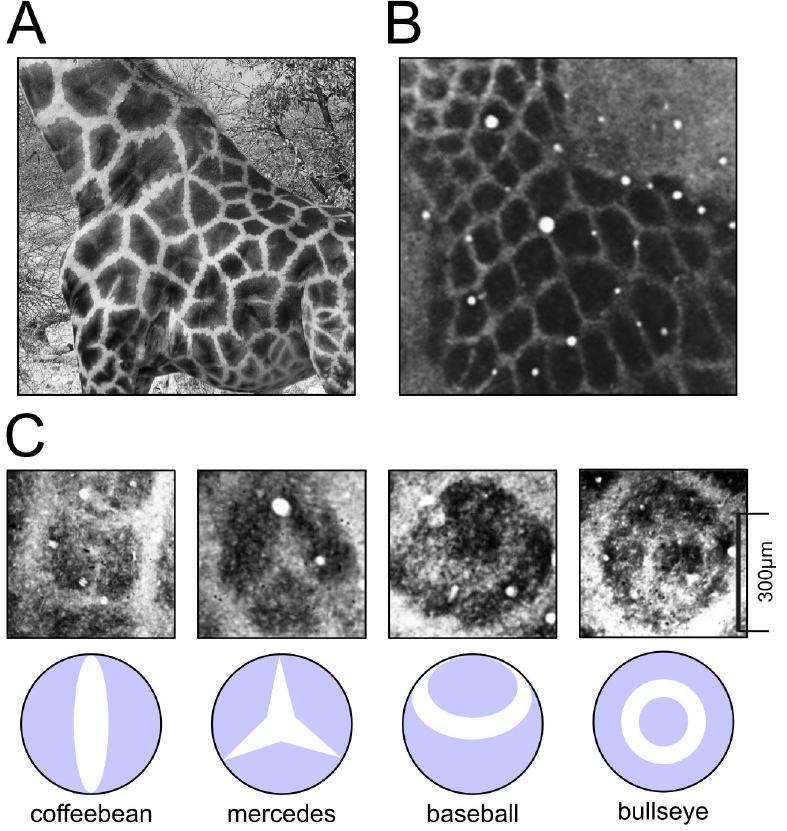
Fig 1. Tessellating domains and sub-domain structure in biological systems. At markedly different length scales, the skin of giraffes and the stained neocortices of rodents display similar arrangements of polygonal domains, many of which appear further divided into sub-structures. A Image of the skin of a giraffe ( Giraffa camelopardalis reticulata ), credited to O. Berger, and described by Koch & Meinhardt (1994; [56]) as a Voronoi tessellation. The dark panels overlap with a vascular structure that is important for thermoregulation. B Image of a tangential section of the cytochrome oxidase stained primary somatosensory cortex of an adult laboratory rat ( Sprague-Dawley ), revealing a pattern of large cortical columns known as ‘barrels’, which have also been described formally as a Voronoi tessellation. C Sub-structures apparent in larger barrel columns have been described in terms of the four categories depicted below, which correspond to the stable patterns generated by a reaction-diffusion model parameterised to amplify modes of increasing spatial frequency. Images in B and C are from Land & Erickson (2005; [57]) and are shown at a common scale. Photograph in A reprinted with permission from Koch A.J. & Meinhardt H., Reviews of Modern Physics, 66, 1481 (1994). Copyright (1994) by the American Physical Society (http://dx.doi.org/10.1103/RevModPhys.66.1481).